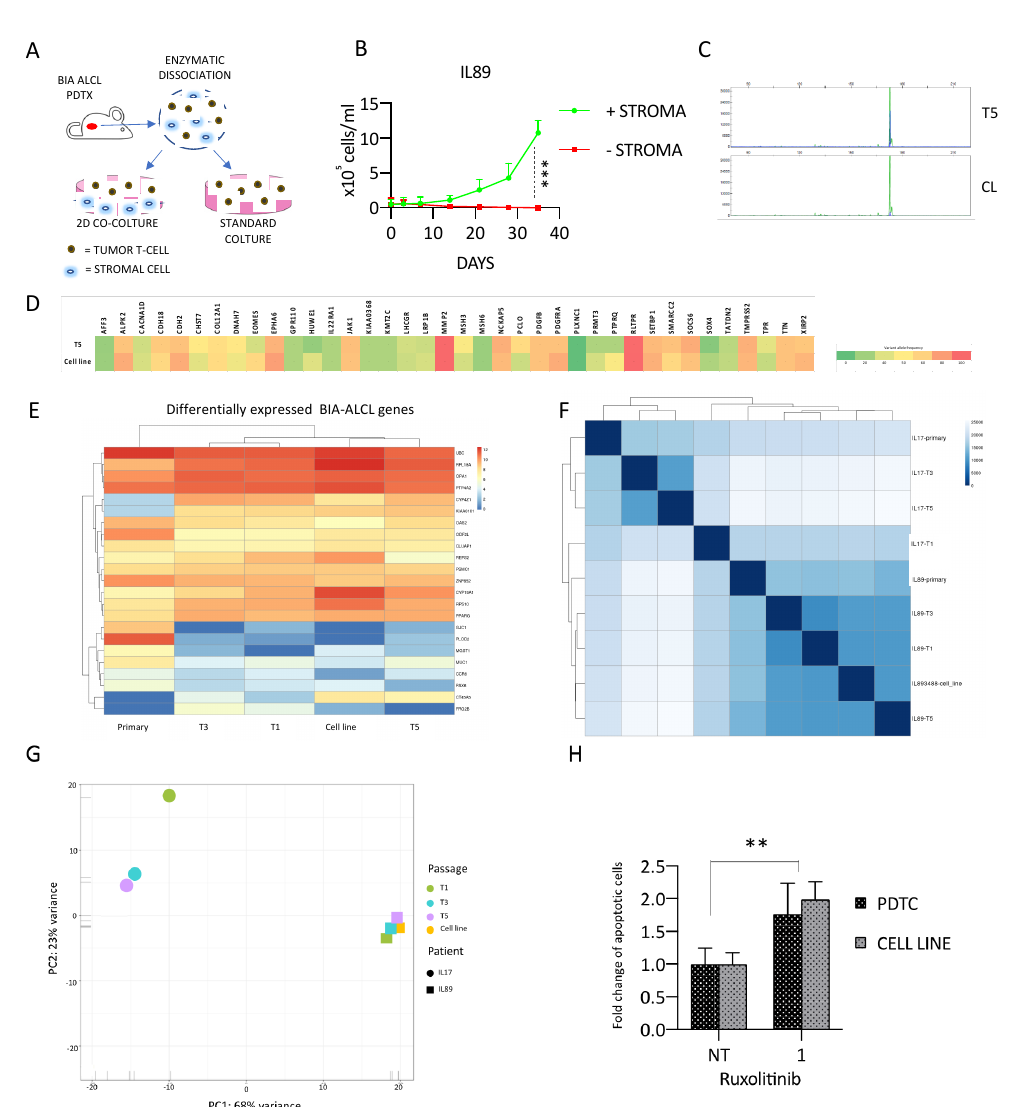
Figure 5. IL89_CL#3488 continuous cell line generation and characterization. ( A ) Schematic IL89_CL#3488 continuous cell line derivation strategy. The patient’s material was digested and cultured overnight. Floating lymphoma cells were isolated and cultured alone or with stromal elements, attached to the plate. ( B ) Growth curve of IL89 cells cultured alone or in the presence of stromal elements. ( C ) TCR gamma specific rearrangement clonality of IL89 PDTX T5 and the IL89_CL#3488 continuous cell line showed the identity of the tumor clone. ( D ) Heatmap of the most significantly mutated genes in IL89 detected by WES shows a similarity between IL89 T5 and the IL89_CL#3488 continuous cell line. The color-code provided is indicative of the VAF. ( E ) RNA expression levels of a breast implant-associated anaplastic large cell lymphoma (BIA-ALCL) gene signature shows a strict association between the IL89 diagnostic sample, PDTX (T1-T3-T5), and the IL89_CL#3488 continuous cell line. ( F ) Unsupervised hierarchical clustering of total RNA sequencing profiles of IL89 (PDTX and cell line) vs, IL17 ALK-ALCL model. Samples of the same models cluster together. ( G ) Principal component analysis based on total RNA sequencing data of IL89 (Primary-PDTX-cell line) vs. IL17 models showed that the expression landscapes of the primary tumors were maintained in the respective PDTX models and that the two di ff erent entities have distinct transcriptomes. The IL89_CL#3488 cell line fits in the same cluster as its primary and PDTX-derived passages. ( H ) IL89_CL#3488 recapitulates the ruxolitinib sensitivity of the corresponding PDTC (72 h, 1 µ M). Data are representative of at least three independent experiments, and values are expressed as the average ± standard deviation. p -values were calculated using the student t -test. ** p < 0.01, *** p <